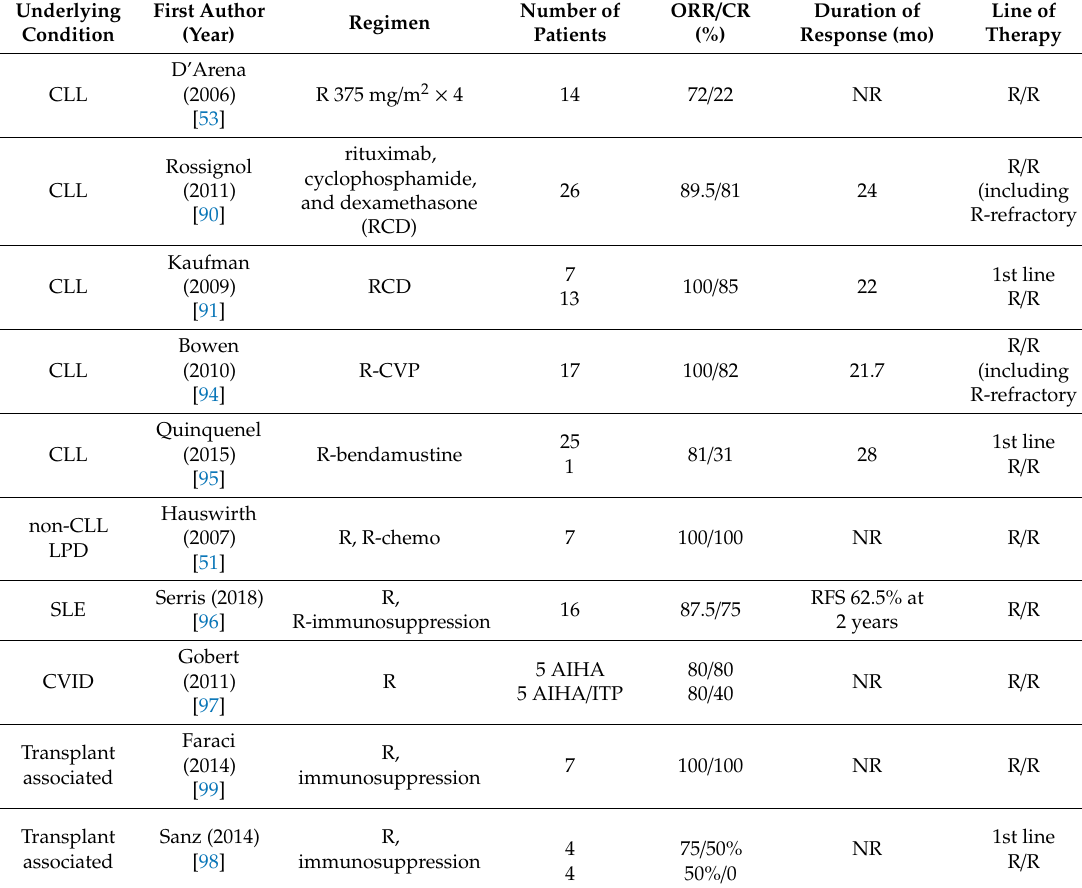
Table 2. Rituximab in secondary